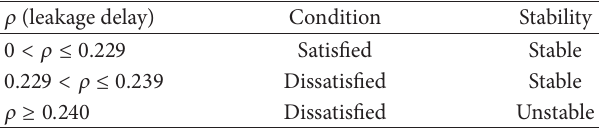
Table 1: Effect of leakage delay on the